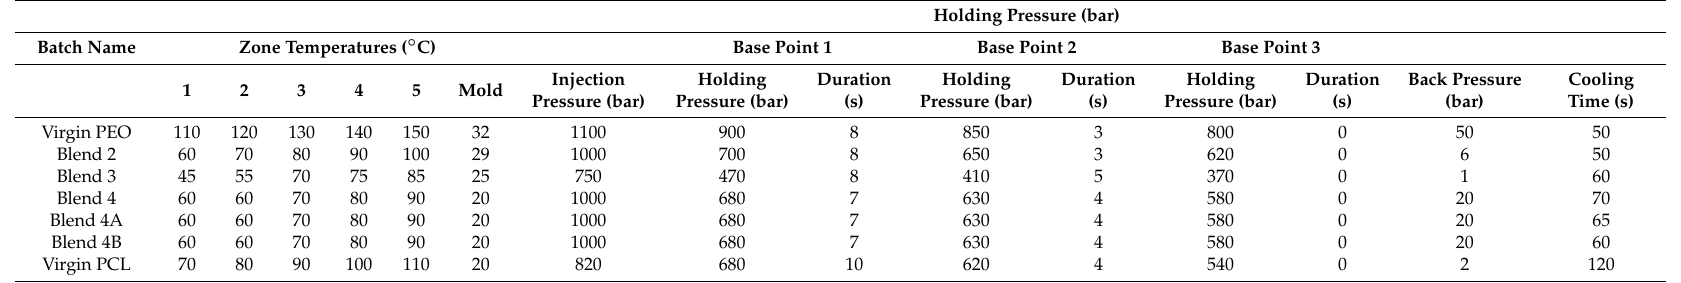
Table A1. Injection Molding Parameters Used in the